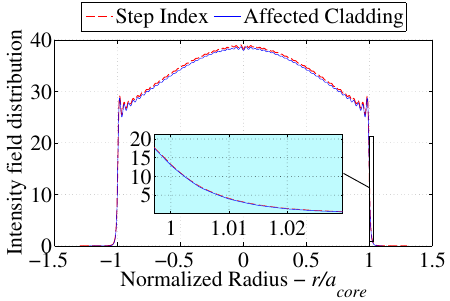
Figure 7. Superimposed light intensity profile comparison for reference step index fibers and diffusion modeled clad fibers.